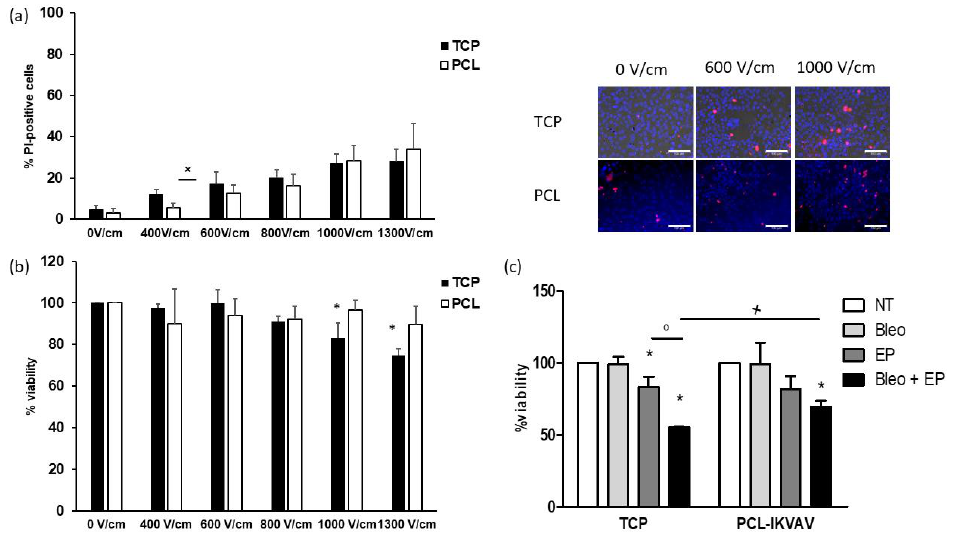
Figure 8. Effects of EP and EP/bleomycin on cell cultures. ( a ) Right panel: PI uptake. Results are expressed as the percent- age of PI-positive cells. x p < 0.05 vs corresponding cultures on tissue-culture polystyrene (TCP); Student’s t test. Left panel: representative micrographs of cultures stained with PI (red) and HOE (blue). Bars: 100 µm. ( b ) Cell viability at 72 h from EP. Results are expressed as percentage from corresponding non-treated cultures (0 V/cm) taken as 100. * p < 0.05 vs cor- responding cultures grown on TCP; Student’s t test. ( c ) Cell viability at 24 h from EP/bleomycin (Bleo). Results are ex- pressed as the percentage from corresponding non-treated cultures (NT). * p < 0.05 vs corresponding untreated cultures; ° p < 0.05 vs corresponding electroporated cultures; x p <0 .05 vs corresponding Bleo + EP-treated cultures.